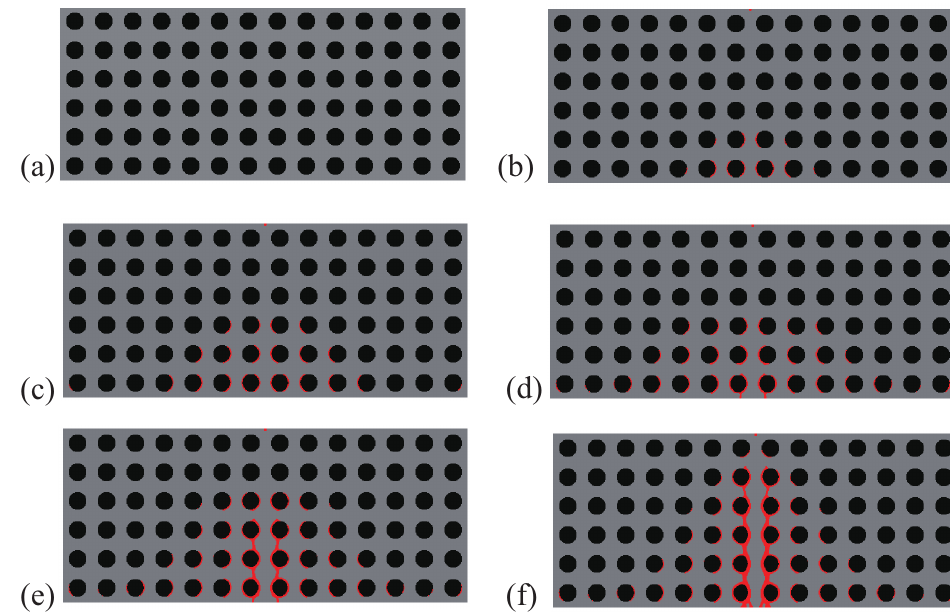
Figure 8. Crack propagation in the larger composite structure subjected to three-point bending, initial design: ( a ) ¯ U = 0 mm; ( b ) ¯ U = 0.25 mm; ( c ) ¯ U = 0.35 mm; ( d ) ¯ U = 0.41 mm; ( e ) ¯ U = 0.44 mm; ( f ) ¯ U = 0.59 mm.